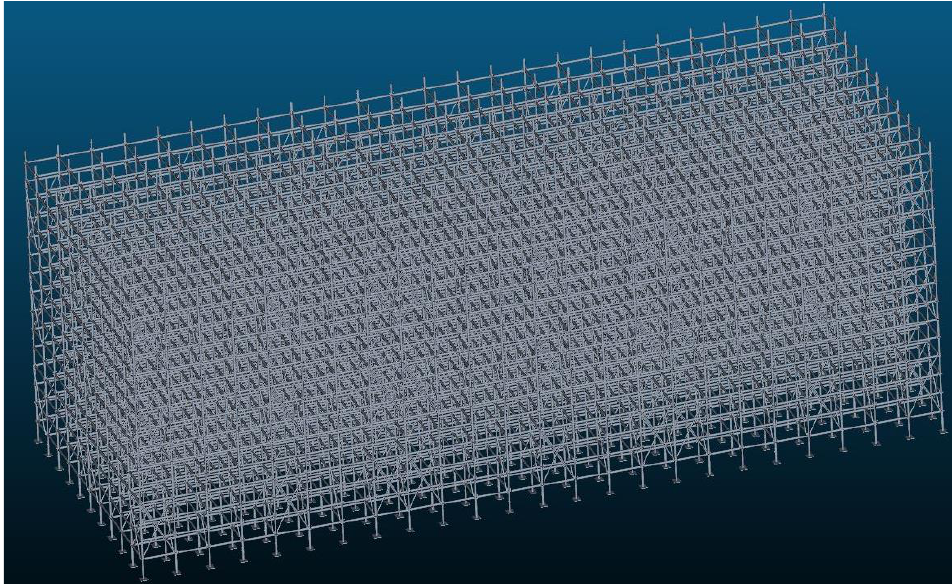
Remote Sens. 2023 , 15 , x FOR PEER REVIEW Figure 15. The data fusion model 1 of the high formwork using the common method. Figure 14. The data fusion model 1 of the high formwork using the common method. Table 5. A summary of results of the different methods.